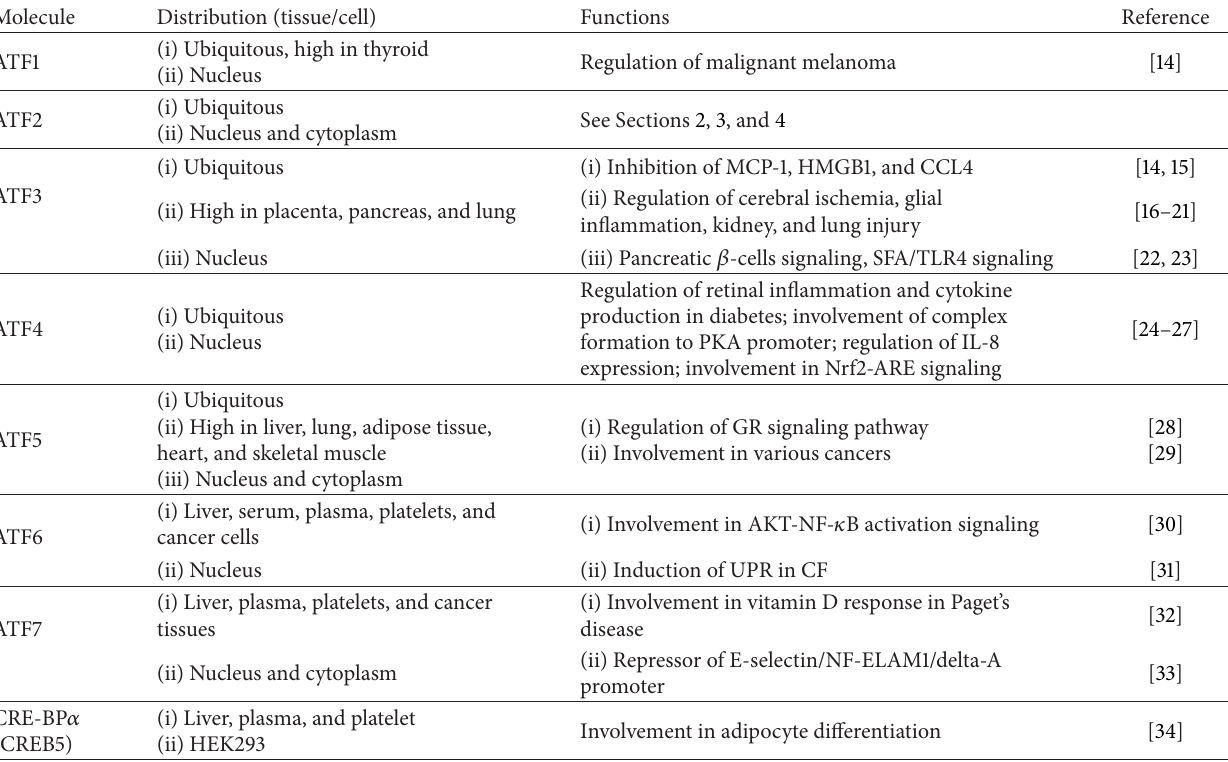
Table 1: ATF family members and their functions in immune